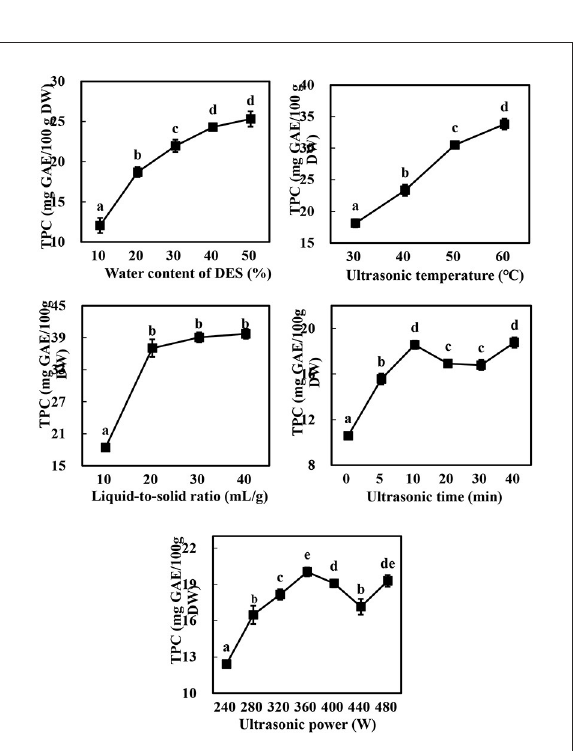
FIGURE2 The effect of water content of DES, liquid-to-solid ratio, ultrasonic temperature, ultrasonic time and ultrasonic power on the TPC of Asparagopsis taxiformis extracts. Different letters indicate significant differences ( p < 0.05).